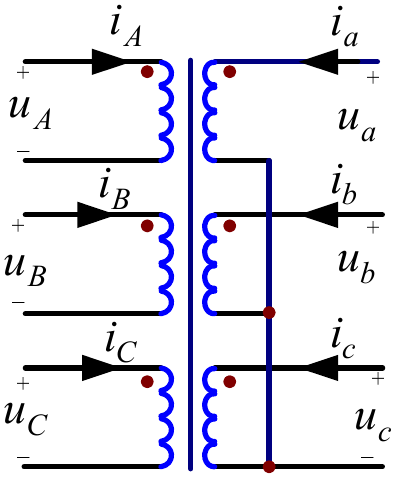
Figure 2. Variables of the six windings in a three-limb